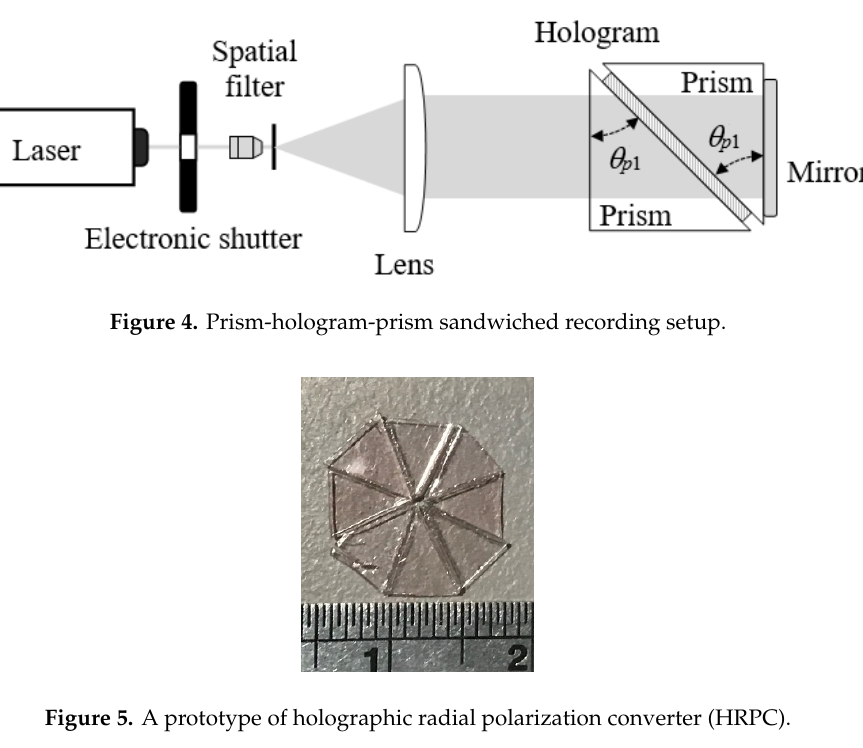
Figure 7. Spectrum diffraction efficiencies for s - and p -polarizations and appearances with s - and p -polarized incident lights. According to the geometry of prism-hologram-prism sandwiched recording setup, the reconstruction wavelength λ 2 (operating wavelength) can be tuned by changing the recording wavelength λ 1 or the base angle θ p 1 of applied right-angle prisms [18]. In Figure 8a, the relationship of reconstruction wavelength λ 2 versus recording wavelength λ 1 is depicted with relevant thickness and refractive index parameters. Considering the most commonly used commercial lasers for holography, the corresponding wavelengths are marked and summarized in Table 1. In addition, the corresponding diffraction angles θ d are all above 81 ° , which can meet the requirement of a large angle in the design. In addition, different from the traditional holographic recording method, this method belongs to a technique of longer wavelength construction for shorter wavelength reconstruction. As shown in Figure 8b, considering a specific recording wavelength of 632.8 nm, the reconstruction wavelength λ 2 (operating wavelength) can be continuously tuned form 300.05 nm to 617.73 nm when the base angle θ d of prism changes from 61.56 ° to 5 ° . In comparison, changing the